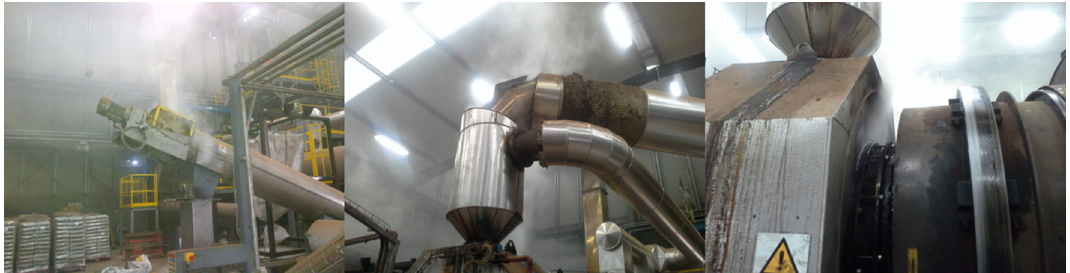
Figure 12. View of the atmosphere inside the production unit, with the gases occupying the space completely and exiting through several holes along the production line.